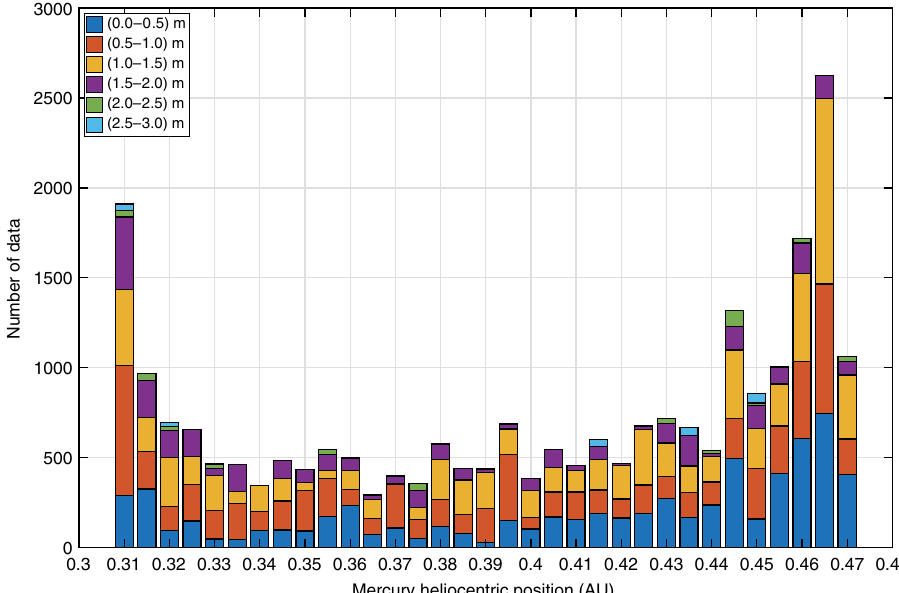
Fig. 2 Data distribution throughout Mercury ’ s orbit. Number of the analyzed measurements as function of the Mercury distance from the Sun in AU. Colors indicate the noise level distribution during each phase bin of Mercury ’ s orbit. The greater part of the data was collected close to Mercury ’ s perihelion and